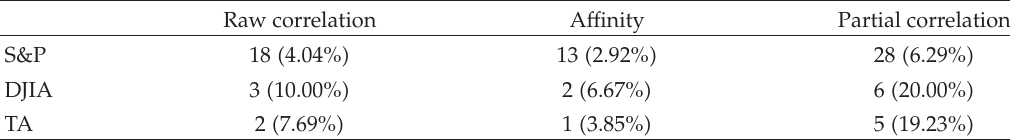
Table 2: Number and percentage (cid:3) out of total (cid:4) of empirical eigenvalues that deviate from the theoretical maximal eigenvalue, λ > λ max , for the raw correlation, a ffi nity, and partial correlation matrices for the three datasets. Raw correlation A ffi nity Partial